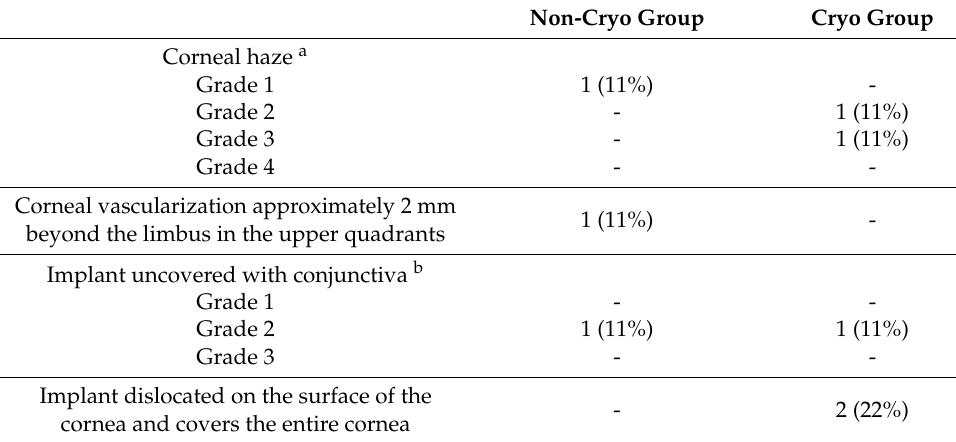
Table 1. Clinical grading of findings observed 7 days after implantation.